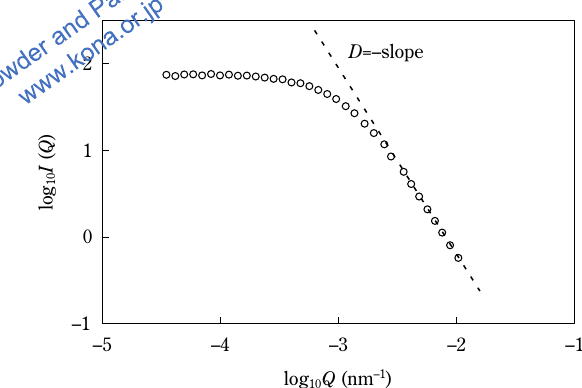
Fig. 3 Typical data of the intensity of light scattered as a function of the scattering wave vector Q. The limiting slope of these data for the higher Q values is interpreted as the fractal dimension, D, assuming that the conditions of the Rayleigh-Gans-Debye in- terpretation are met.